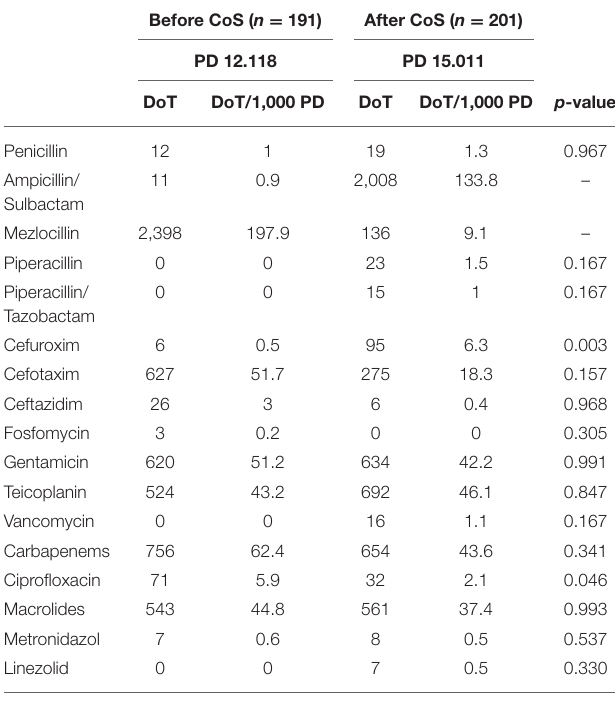
TABLE 6 | Antibiotic use measured by days of therapy (DoT) and DoT per 1,000 patient-days (PD) between the two cohorts before and after the introduction of colonization screening (CoS), limited to the birth weight category of 1,000–1,499g.